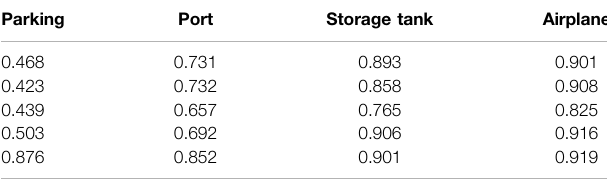
TABLE 3 | Detection results of a single target by different